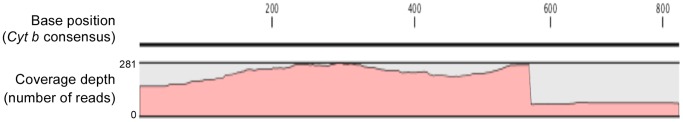
Example of a coverage plot for Cyt b mapping generated by CLC genomics workbench v 4.9.Data shown represent reads from one population-pool (N = 6 individuals).